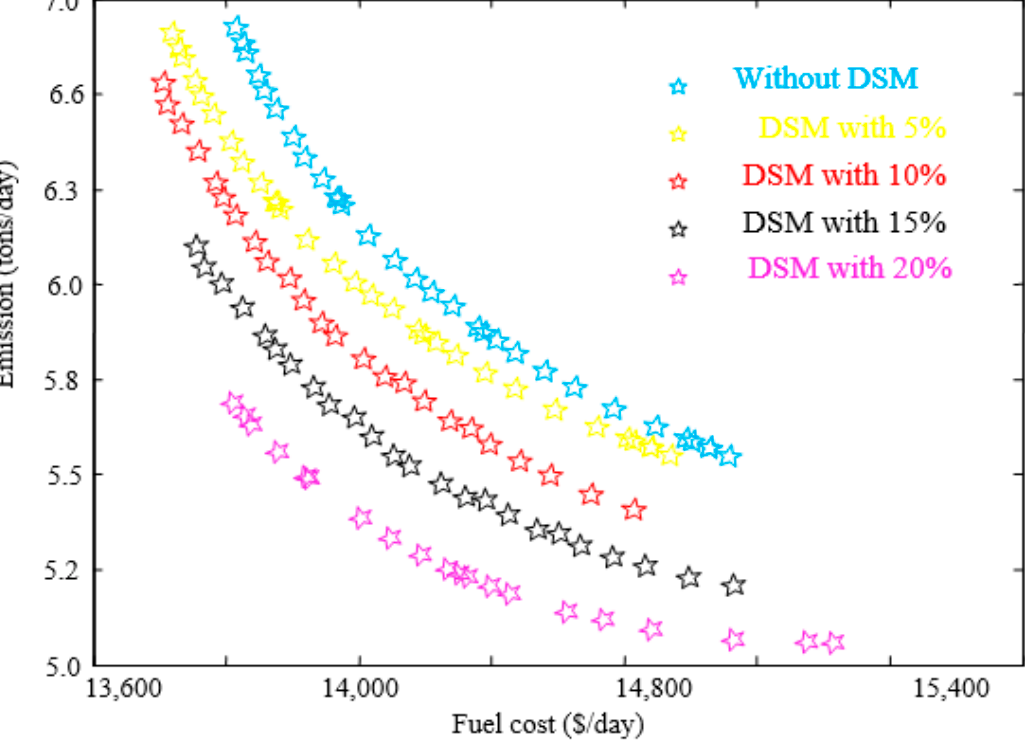
Figure 10. The sets of Pareto MODEED issues by various levels off DSM participation.